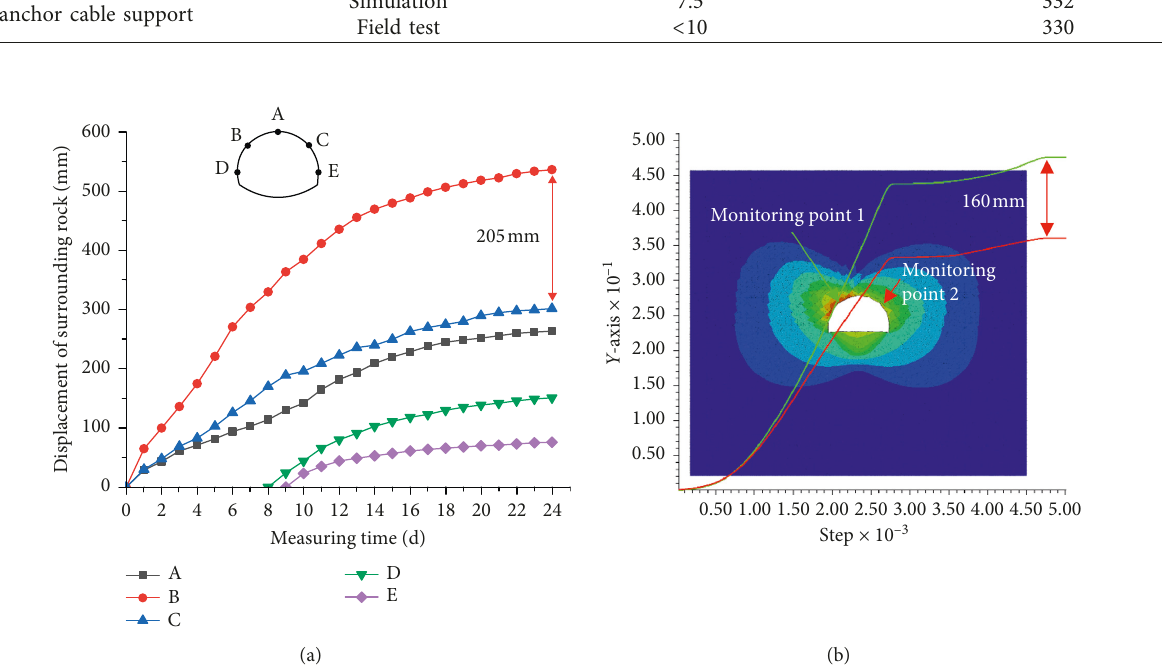
Figure 23: (a) Field test results. (b) Numerical simulation